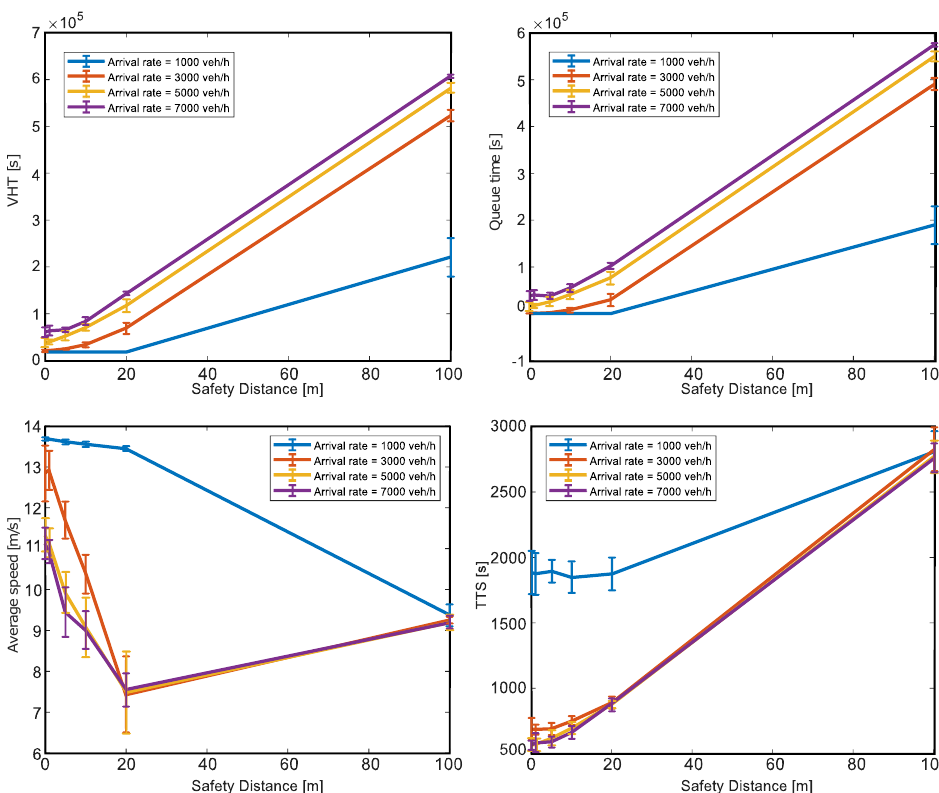
Figure 9. Simulation results for safety distance sensitivity